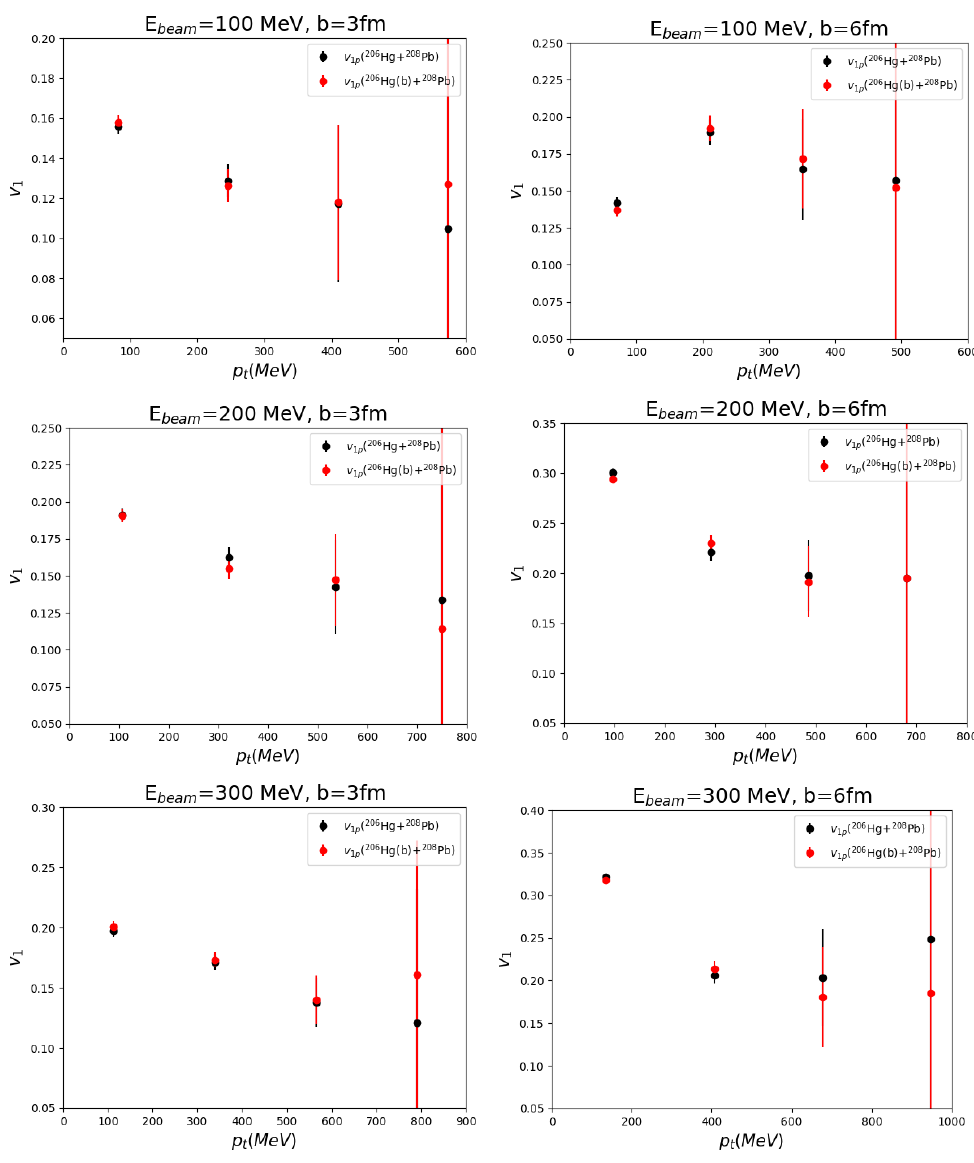
Figure 5. The directed flow v 1 of protons in 206 Hg (nonbubble) + 208 Pb (in black) and 206 Hg (bubble) + 208 Pb (in red)